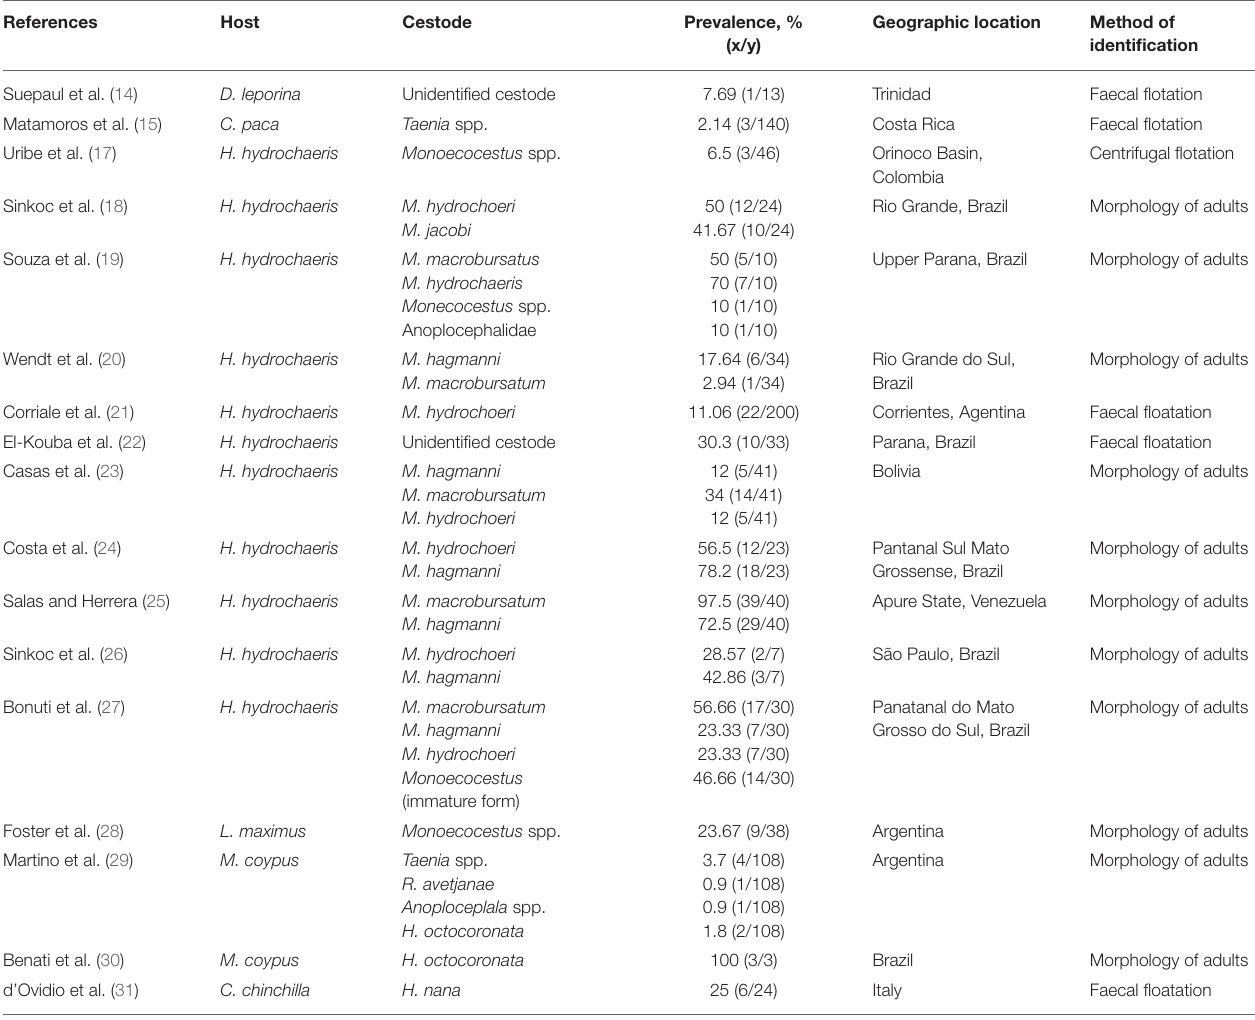
TABLE 1 | Prevalence of adult cestodes of hystricomorphic rodents and various geographical locations.